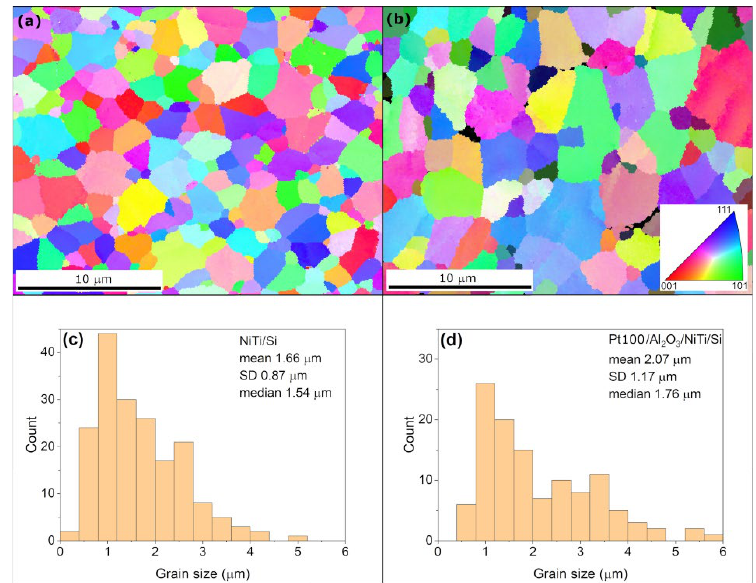
Figure 2. The color electron backscattering diffraction (EBSD) maps representing the orientation of the grains through inverse pole figure (IPF) color-coding in selected surface areas of NiTi ( a ) and Pt100 ( b ) samples and the corresponding grain size distributions in NiTi ( c ) and Pt100 ( d ) samples. The color code for IPF orientation is given in the inset of part ( b ).